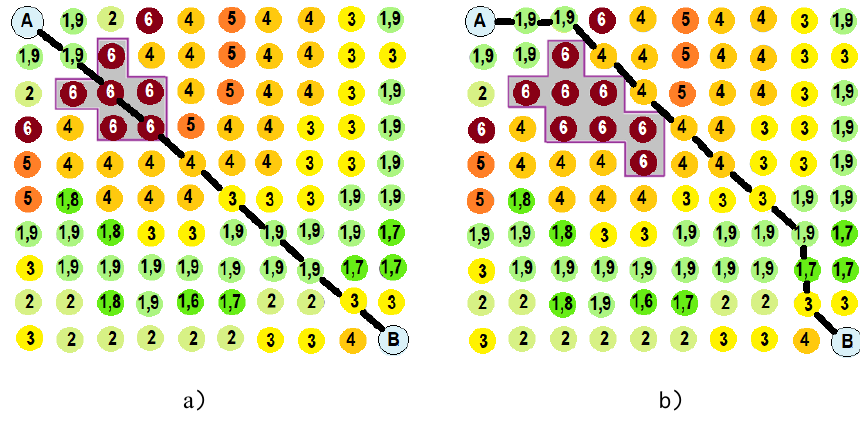
Fig. 4. Optimal routes with significant PDOP variations.